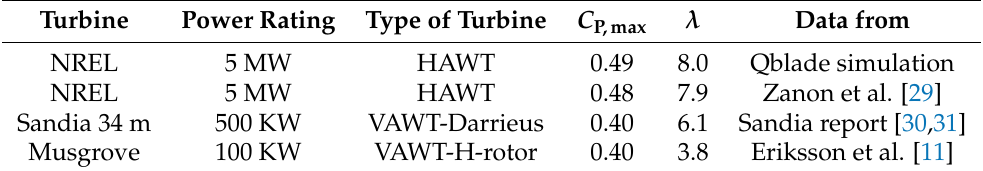
Table 2. HAWT and VAWT turbines with characteristic C P,max and corresponding λ . The source of the data is specified in the last